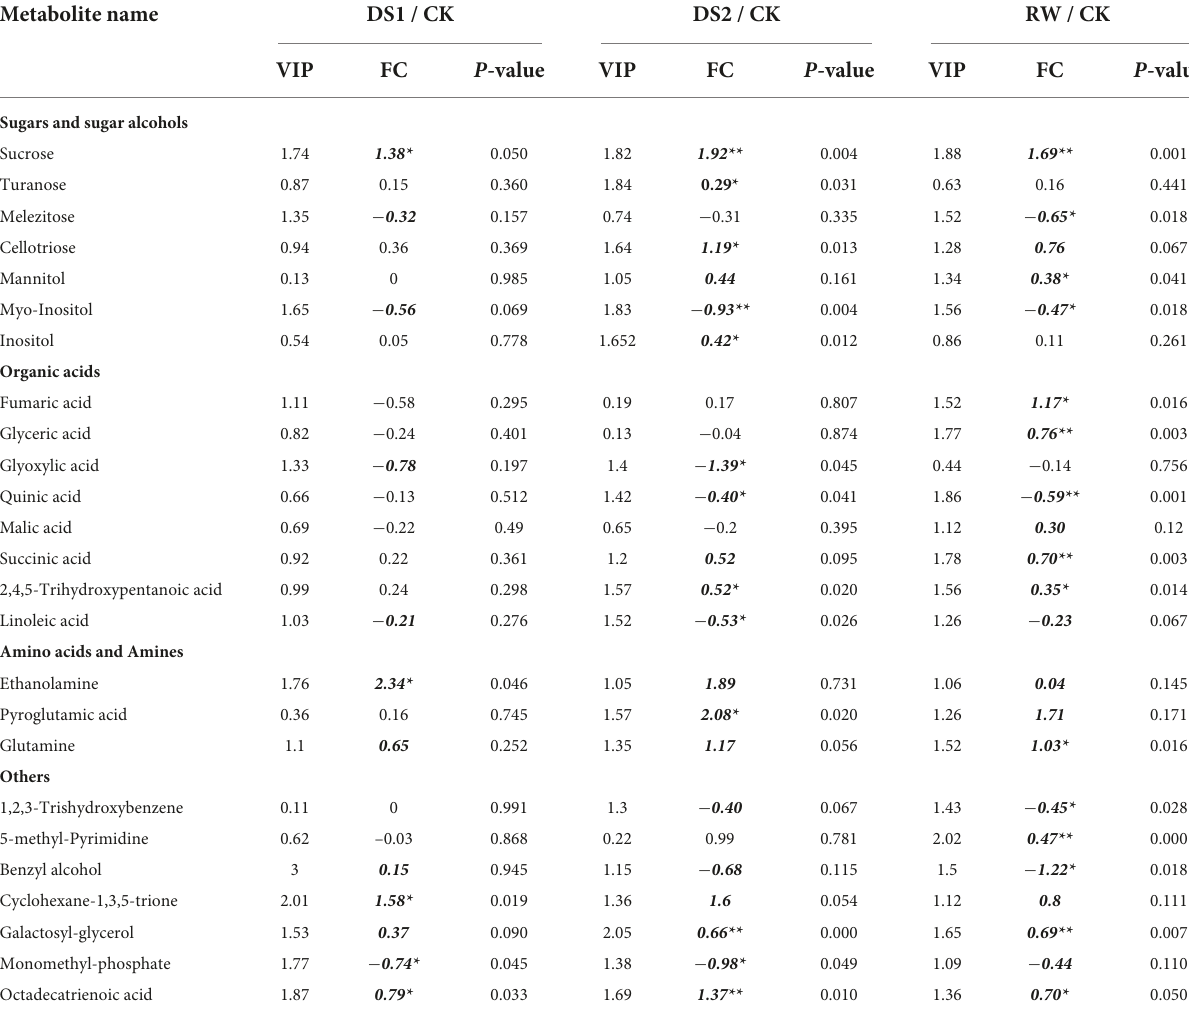
TABLE 1 Fold changes (FC) of significantly differential primary metabolites in leaves of C. sinensis cv. Ruixue in response to drought